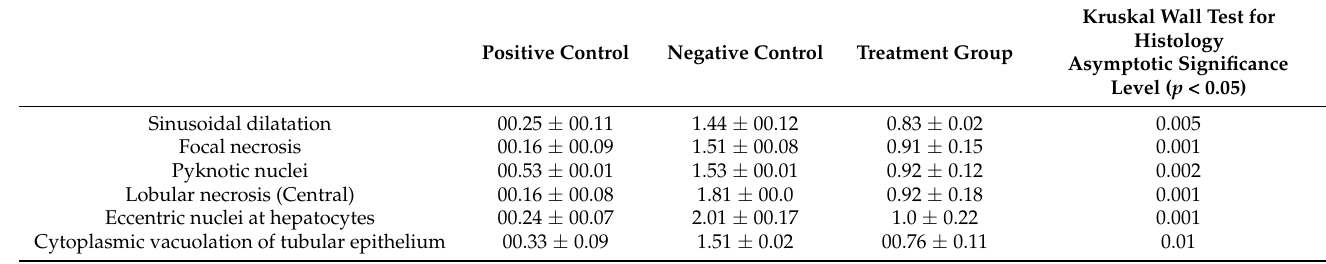
Table 3. Histological parameters of liver in cigarette smoke and alloxan-induced diabetes.